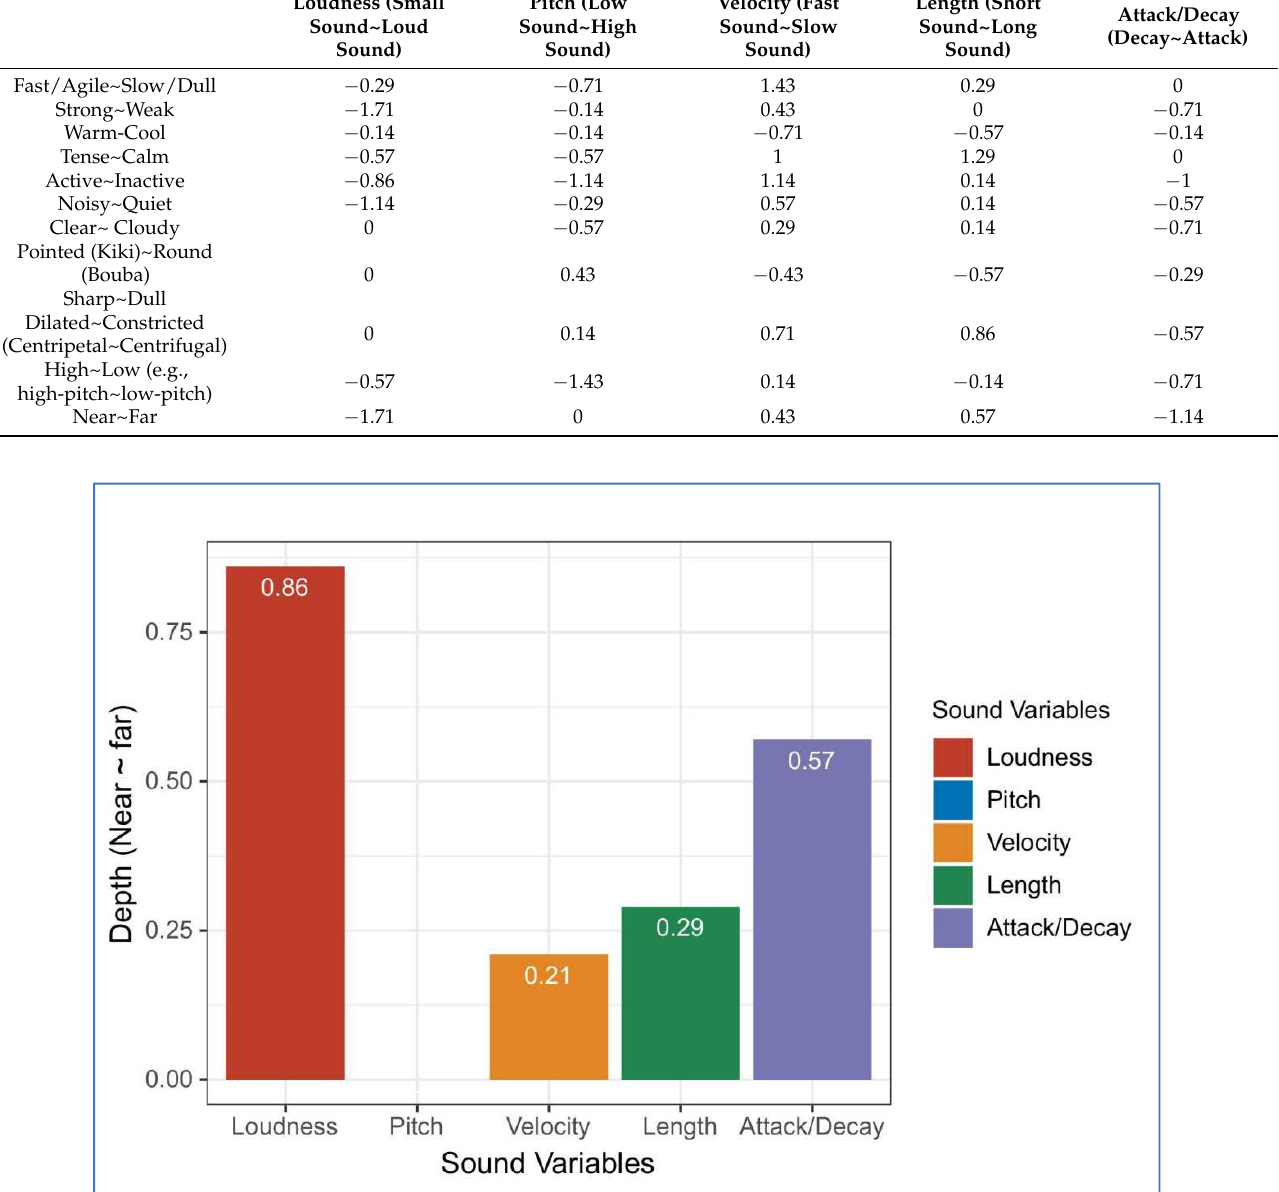
Table 7. Matching results of sound variables with adjective pairs.